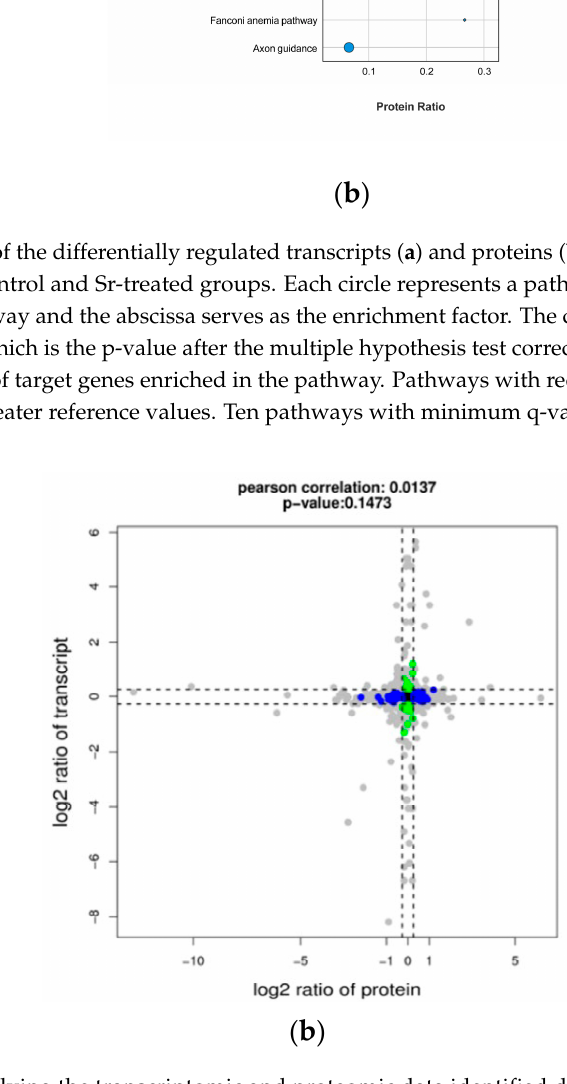
Figure 2. KEGG-enriched pathways of the differentially regulated transcripts ( a ) and proteins ( b ) in bovine chondrocytes between the control and Sr-treated groups. Each circle represents a pathway. The ordinate is the name of the pathway and the abscissa serves as the enrichment factor. The color of the circle represents the q-value, which is the p-value after the multiple hypothesis test correction. The circle size indicates the number of target genes enriched in the pathway. Pathways with redder colors and larger circles exhibited greater reference values. Ten pathways with minimum q-values were displayed in this study.